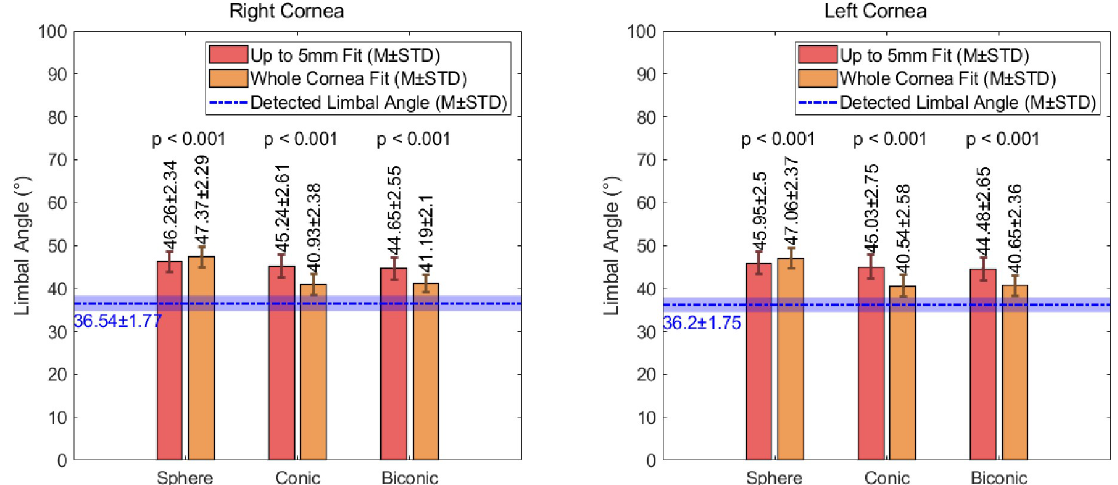
Fig 8. Observed values of the angle at the limbus for corneal surfaces fitted using spherical, conic and biconic techniques.